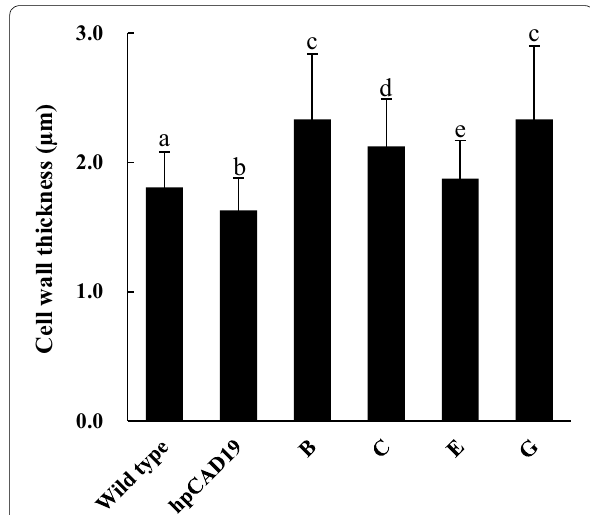
Fig. 4 Cell wall thickness of xylem cells measured by imaging analysis. Different letters indicate statistically significant differences between the various lines at P < 0.01. A statistical difference was determined by one-way ANOVA followed by Tukey–Kramer multiple comparison tests. Error bars indicate the standard